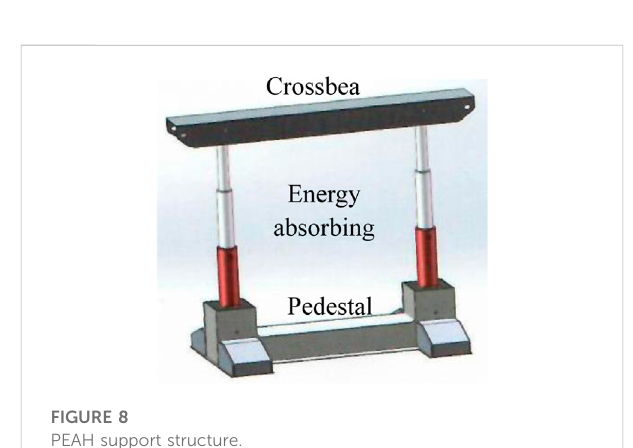
FIGURE 8 PEAH support